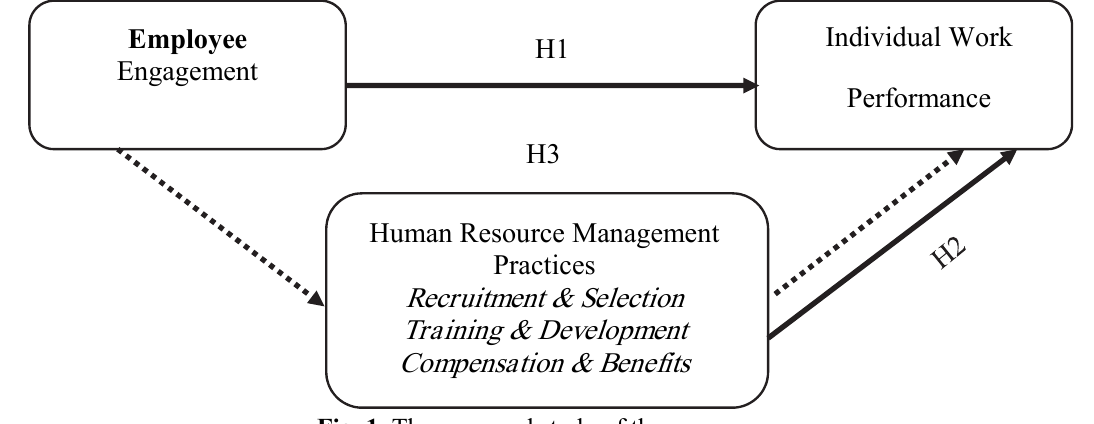
Fig. 1. The proposed study of the